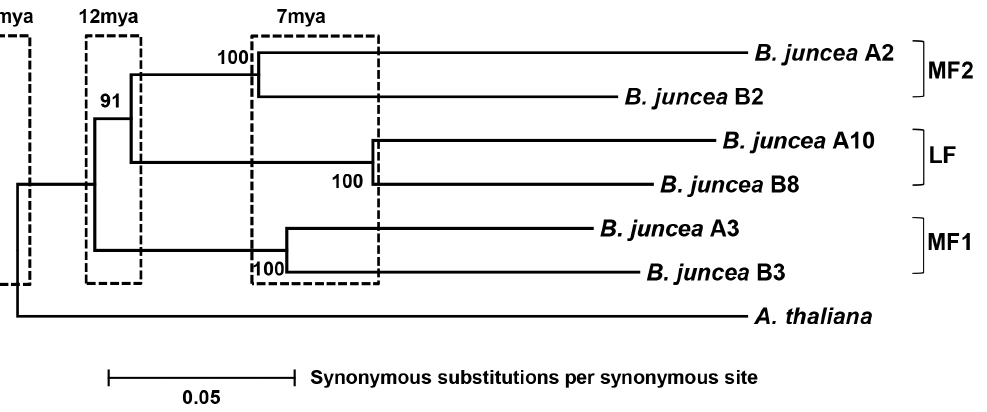
Figure 2. Neighbour-joining tree constructed on the basis of distances estimated from synonymous base substitutions of the concatenated nucleotide sequences of 11 genes retained in all the six R blocks of B.juncea . The numbers on the nodes represent percentage from bootstrap analysis of 1000 replicates. A. thaliana-Brassica divergence time , 15 mya; Brassica A genome paralogue and B genome paralogue divergence time , 12 mya; A and B genome homoeologue divergence time , 7 mya.